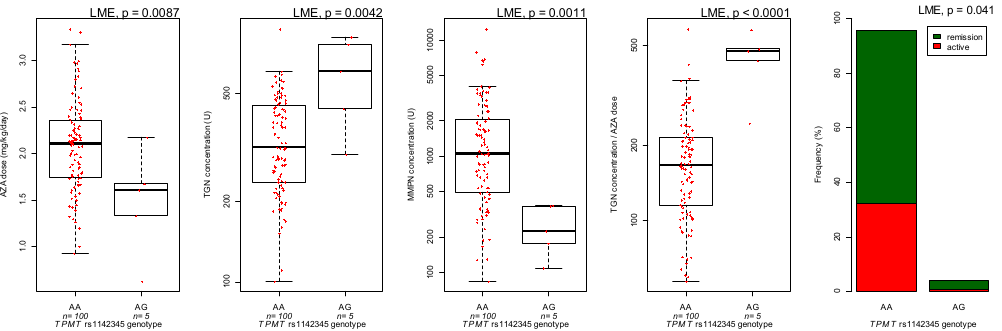
TPMT rs1142345 genotype